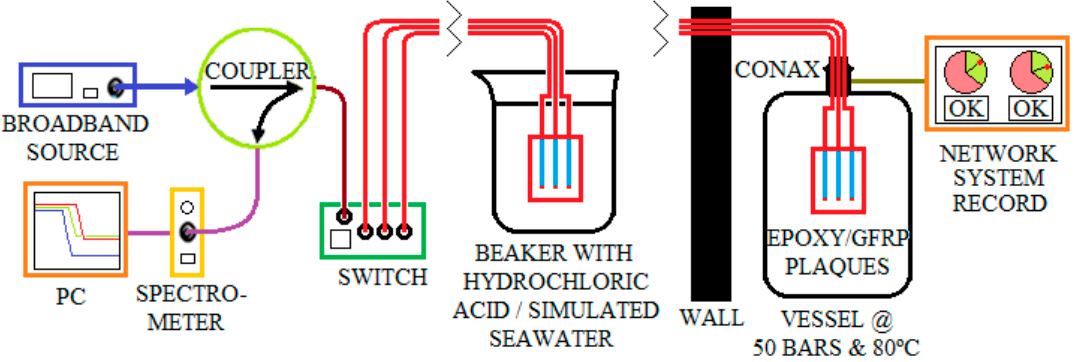
Figure 2. Interrogation setup. The inset shows the arrangement for high-temperature/high-pressure experiments (adapted from Reference [7]).